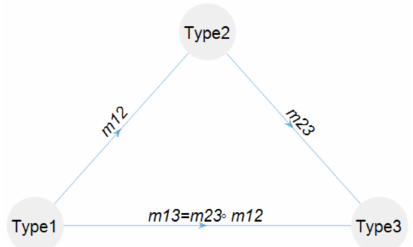
Figure 4. A category with three types: Type1, Type2, and Type3. The morphisms m 12 : Type 1 → Type 2 and m 23 : Type 2 → Type 3 are specified. The morphism m 13 is a compo- sition of m 23 after m 13—it transforms Type1 to Type3 by transforming Type1 to Type2, then Type2 to